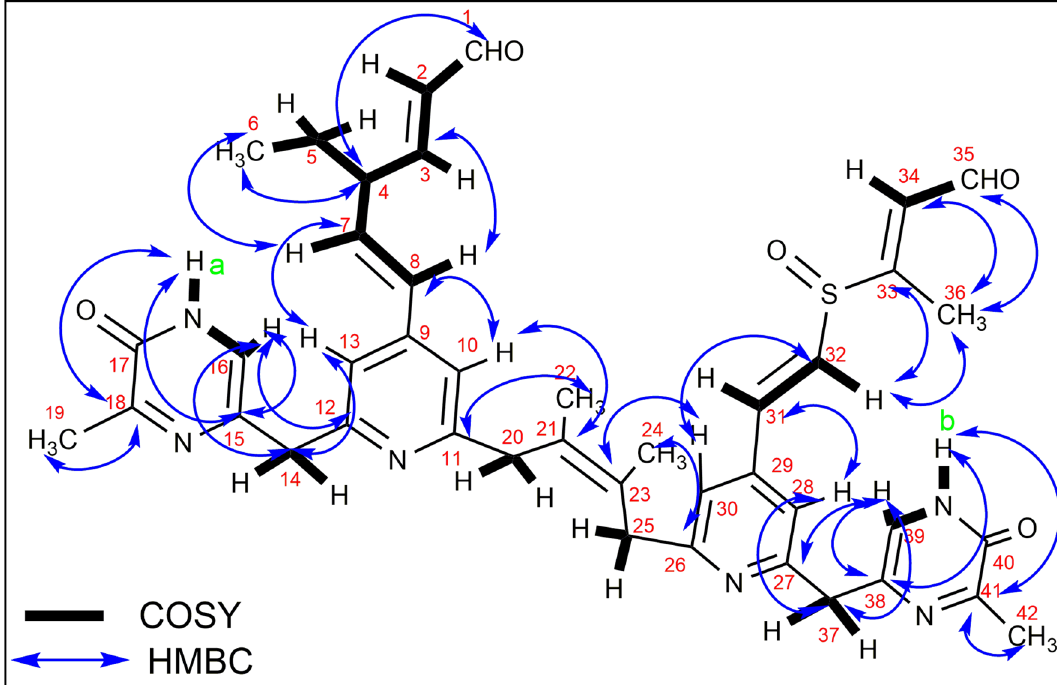
Figure 3. 2D NMR (HMBC) correlation of